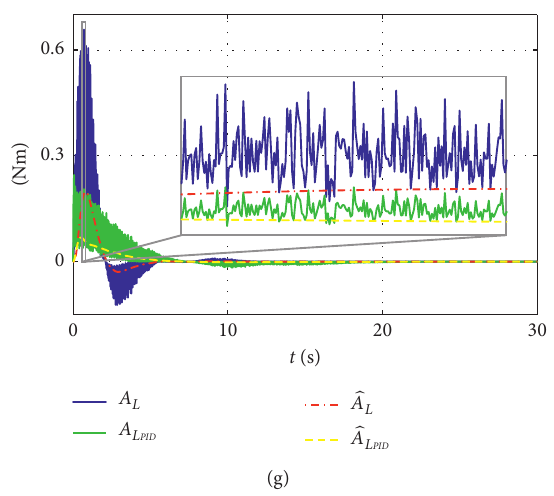
Figure 2: Simulation